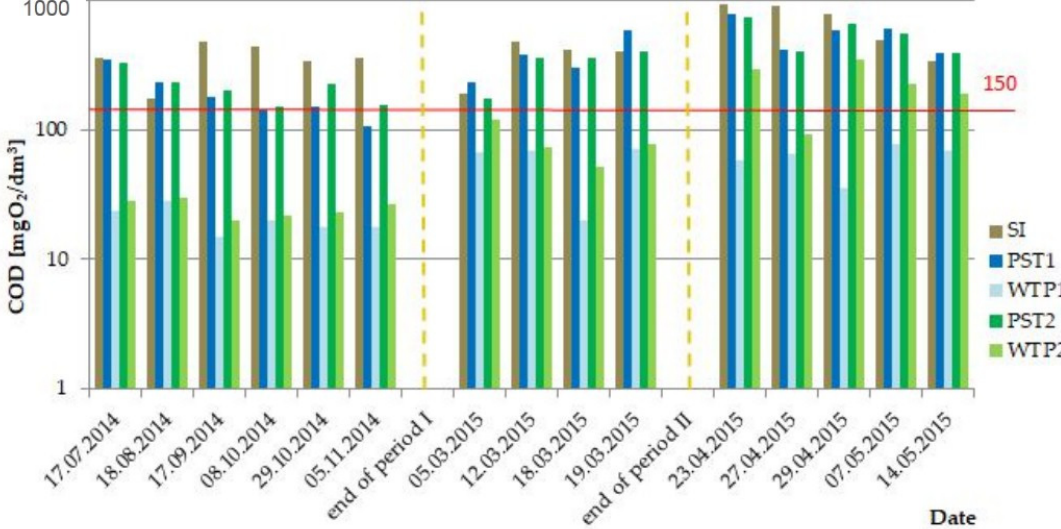
Figure 3. Chemical oxygen demand (COD) in sewage inlet (SI), after primary settling tank (PST1 and PST2), and after WTP1 and WTP2.